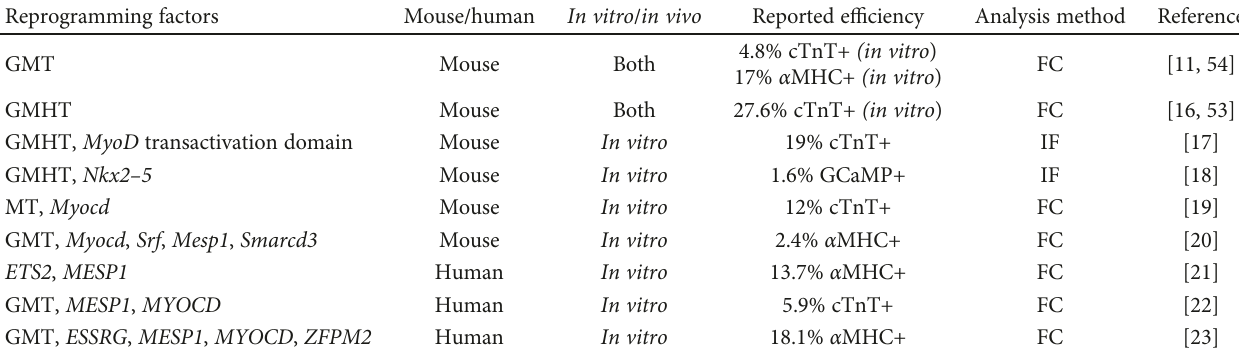
Table 1: Summary of transcription factor direct cardiac reprogramming results.